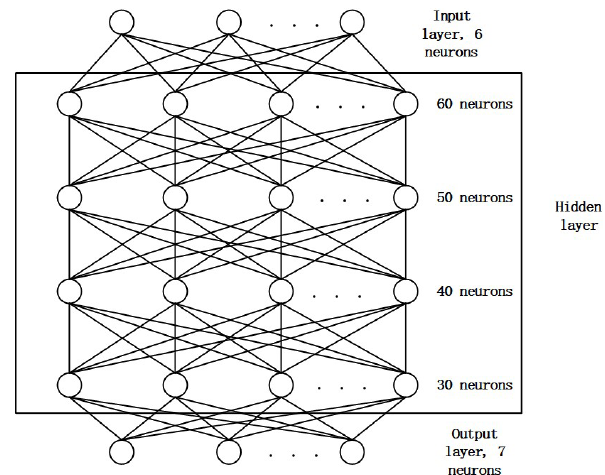
Figure 2. Structure of the neural